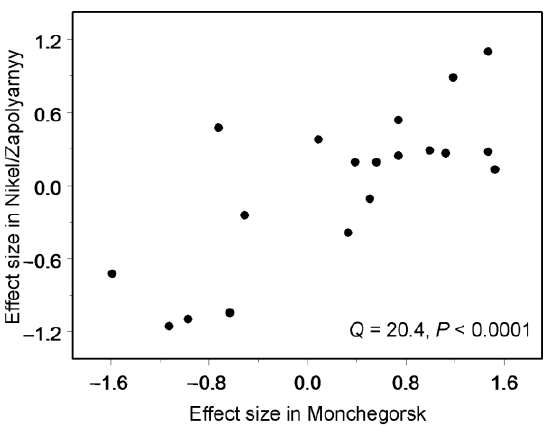
Figure 5. Meta-regression of the effects of distance from the nearest polluter on the abundance of individual Lepidoptera species around Nikel/Zapolyarnyy to the effects on the abundances of the same species around Monchegorsk.